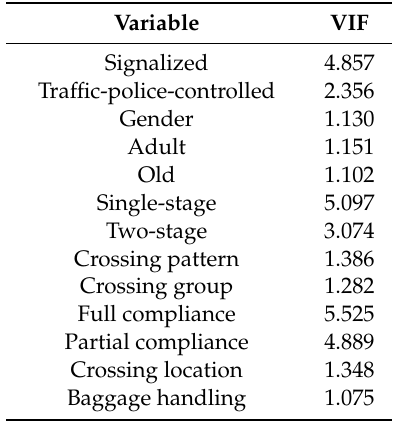
Table A1. Multicollinearity (VIF) test